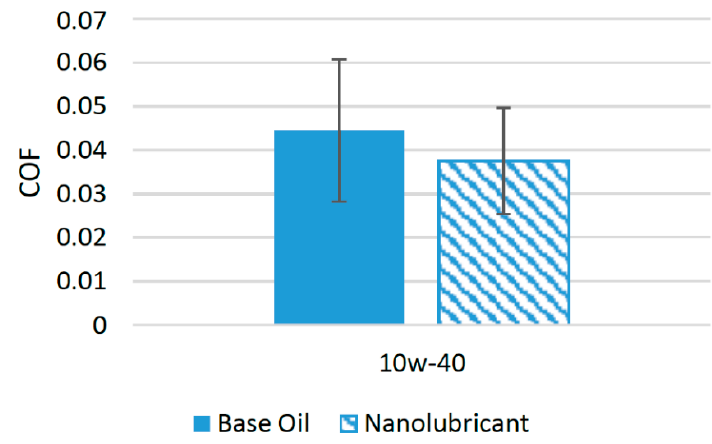
Figure 6. Effect of ZnO NPs on the friction performance of synthetic lubricants.